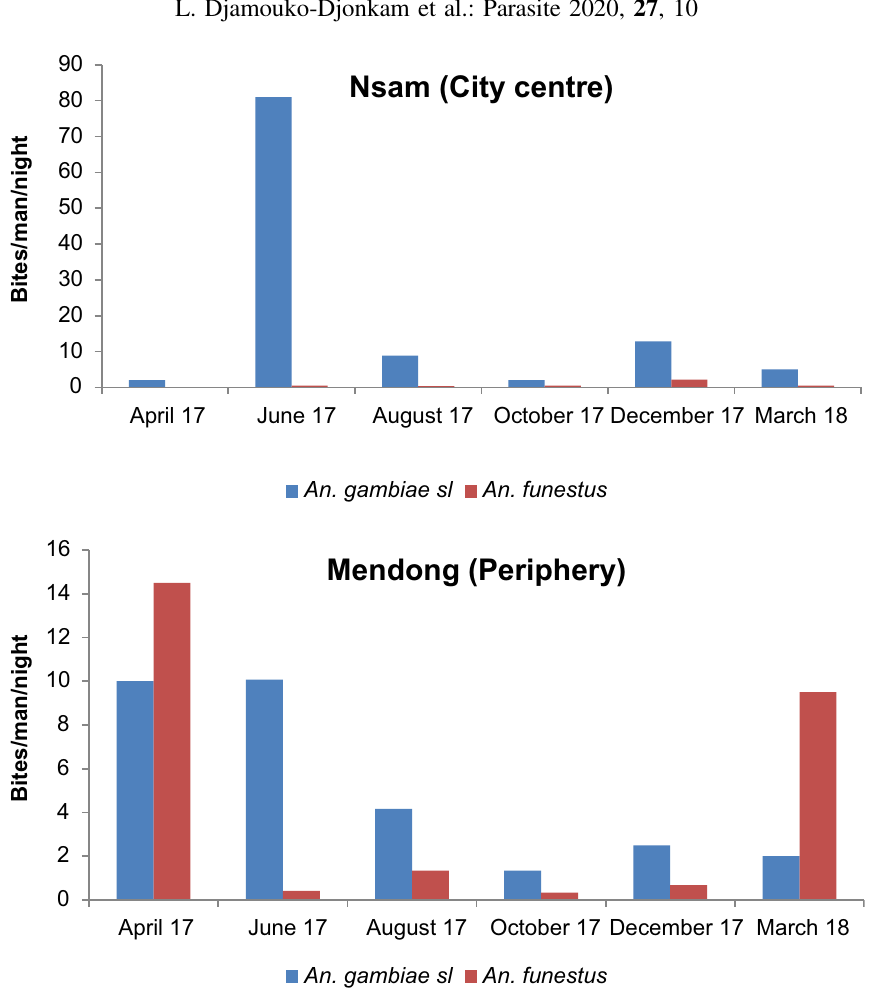
Figure 2. Monthly variation of biting densities of An. gambiae s.l. and An. funestus collected using HLC in Mendong and Nsam from April 2017 to March